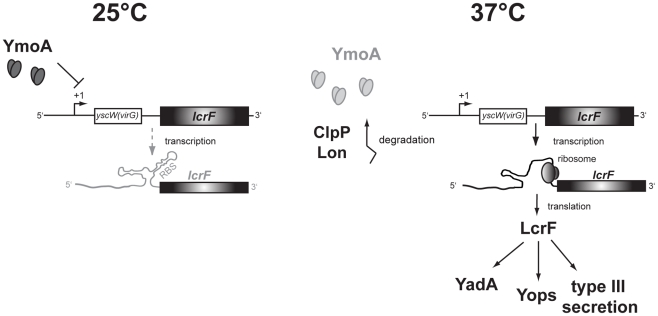
Model of thermoregulated expression of LcrF synthesis.At moderate growth temperature, transcription of the yscW-lcrF operon is repressed by the regulatory protein YmoA through sequences located downstream of the transcription initiation site. In addition, translation of the lcrF transcript is blocked through the formation of a two-stemloop structure within the intergenic region which sequesters the RBS and prevents access of the ribosomes. After a sudden temperature upshift upon host entry, YmoA is rapidly degraded by the ClpP and Lon proteases, leading to an enhanced transcription of the yscW-lcrF operon. Furthermore, thermally-induced conformational changes allow access of ribosomes and translation of the lcrF transcript leading to LcrF synthesis and induction of all LcrF-dependent virulence genes of Yersinia.